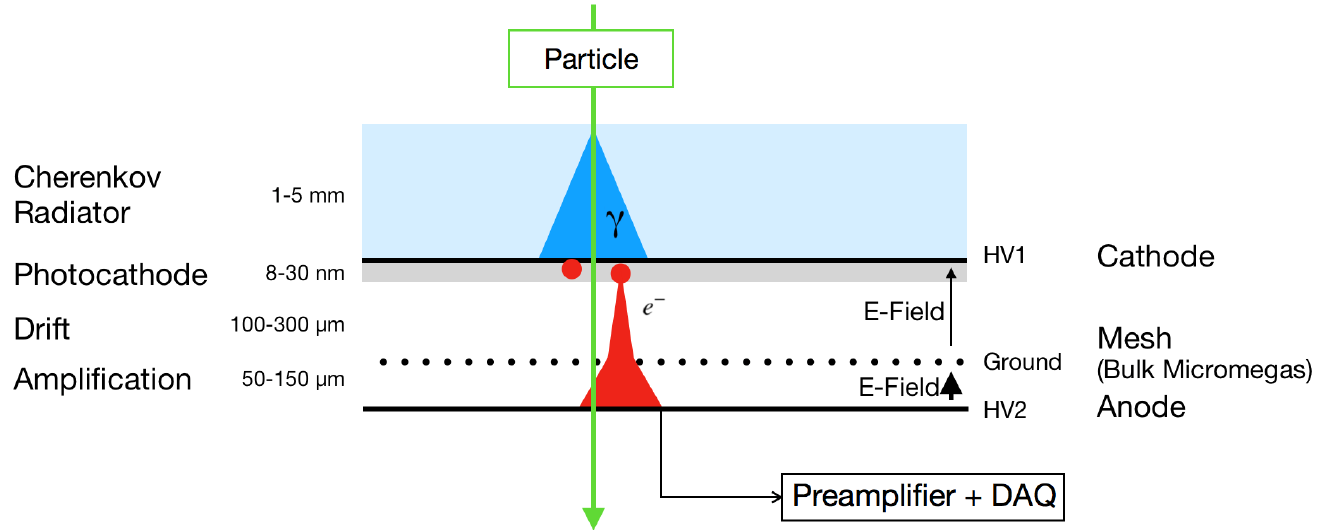
Figure 26. The PICOSEC-Micromegas detection concept, described in detail in the text. Electrons emitted from the photocathode surface experience the same electric field along the same distance to the mesh. The gaseous volume is needed only to amplify the electrons and to induce a readable signal on the anode. A Micromegas-like detector with a grounded mesh between two electric fields with parallel field lines is chosen. A negative voltage is applied to the cathode and a positive voltage to the anode to provide a unidirectional electric field in both regions. With the grounded field, the voltage will only drop until the mesh when a spark occurs. The other region is inversely polarized and stays unaffected by the spark. Additionally, fields can be independently tuned with a grounded mesh, and field scans are easily